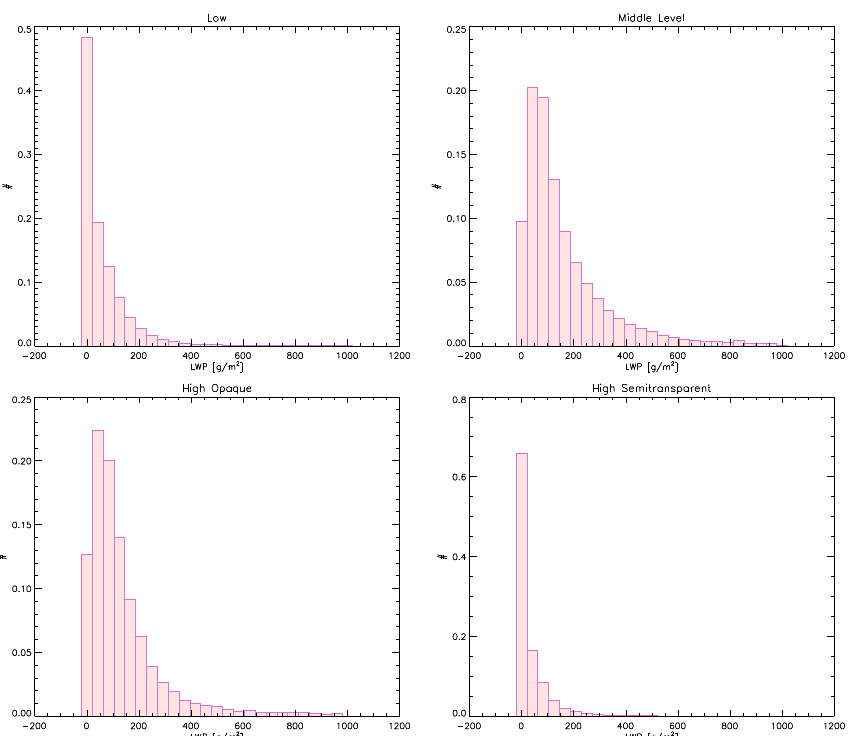
Fig. 2. Frequency distribution of LWP for 4 cloud types, average from the SEVIRI disc for 7 October 2009. Upper left: low clouds; upper right: middle level; lower left: high opaque; lower right: high